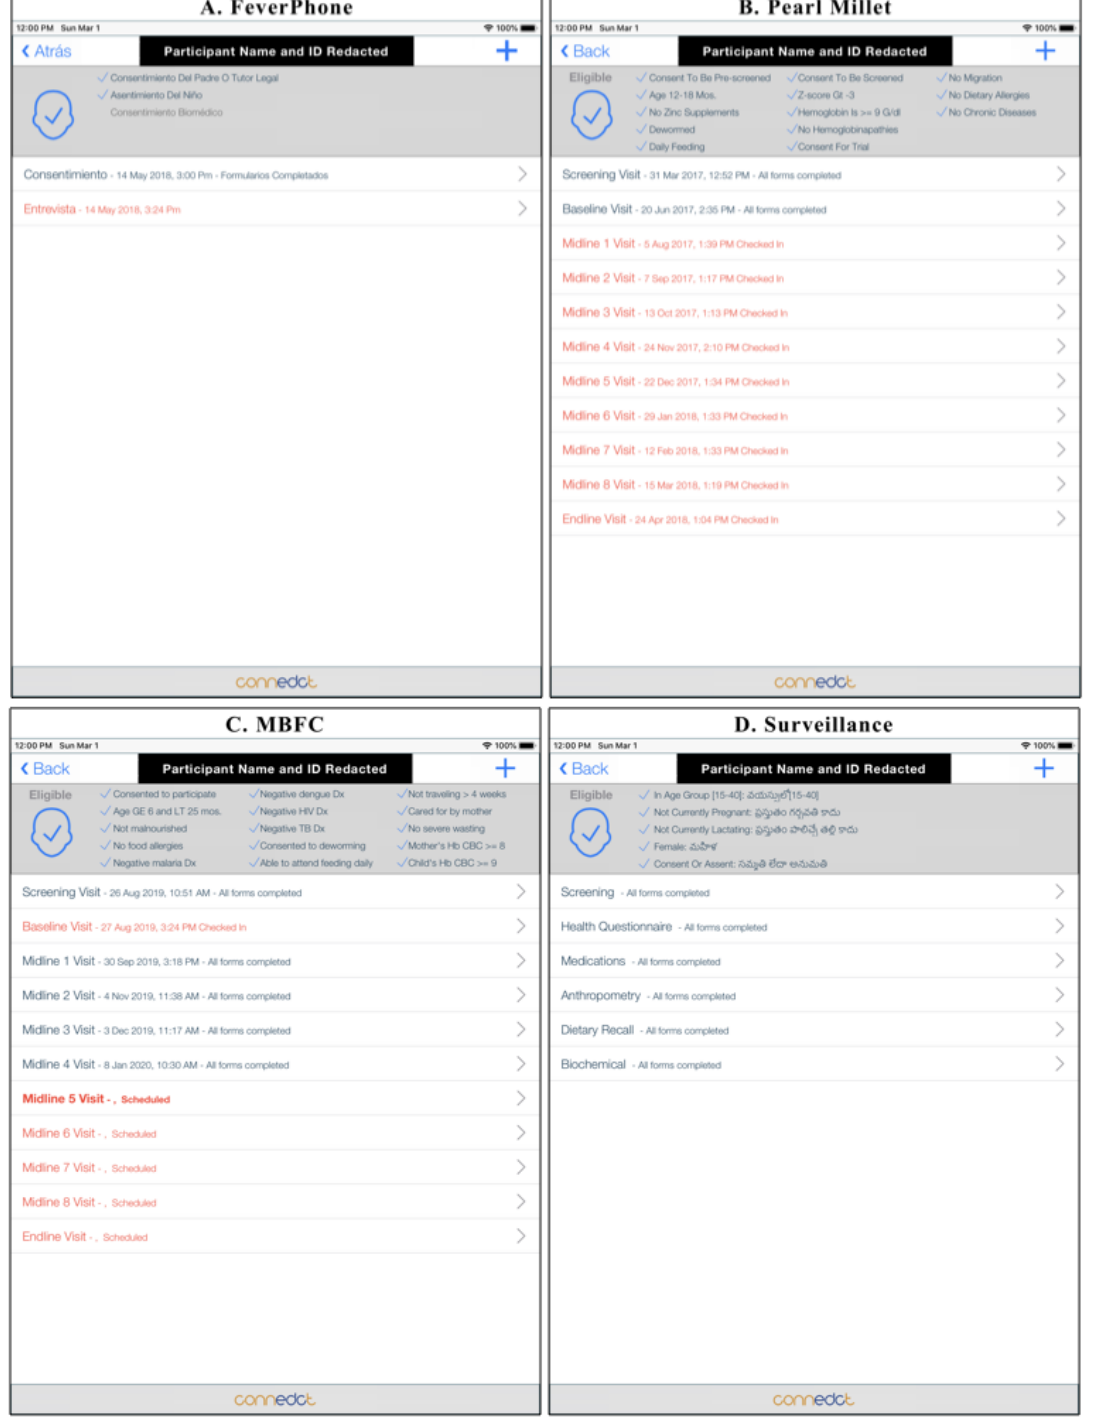
Figure 2. Schedule of visits for (A) clinical setting: FeverPhone, Ecuador; (B) RCT, Mumbai; (C) RCT, South India; (D) surveillance, South India. RCT: randomized controlled